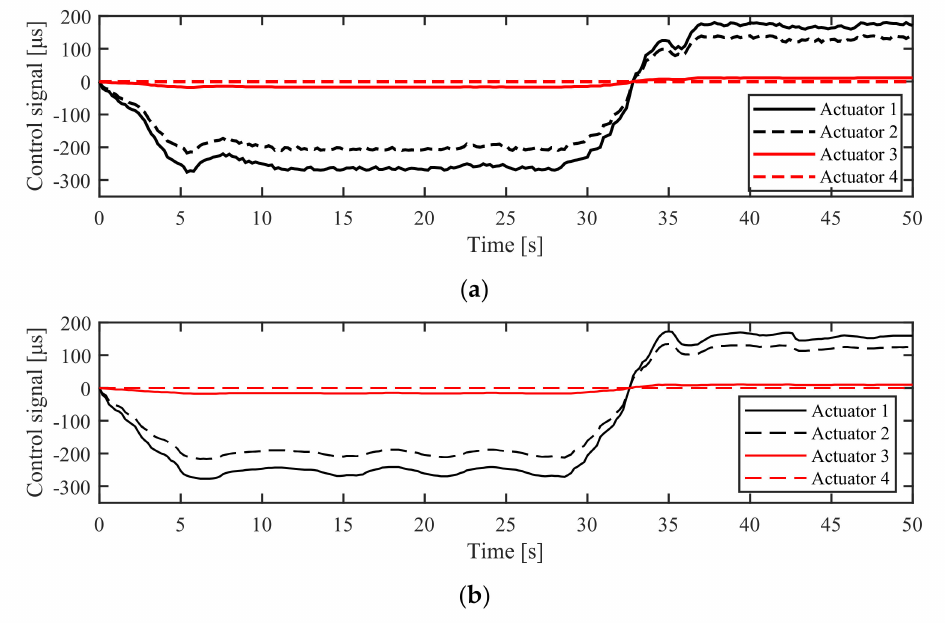
Figure 28. The experimental control signal in AM mode: ( a ) Proposed controller; ( b ) PID.